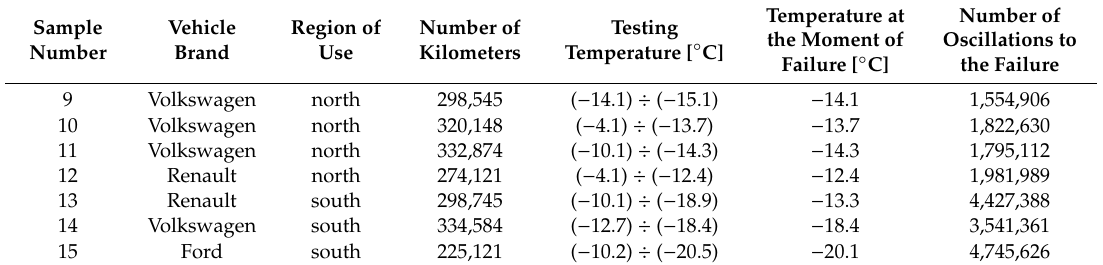
Table 6. The results of testing cu ff s at temperatures from − 4 ◦ C to − 20 ◦